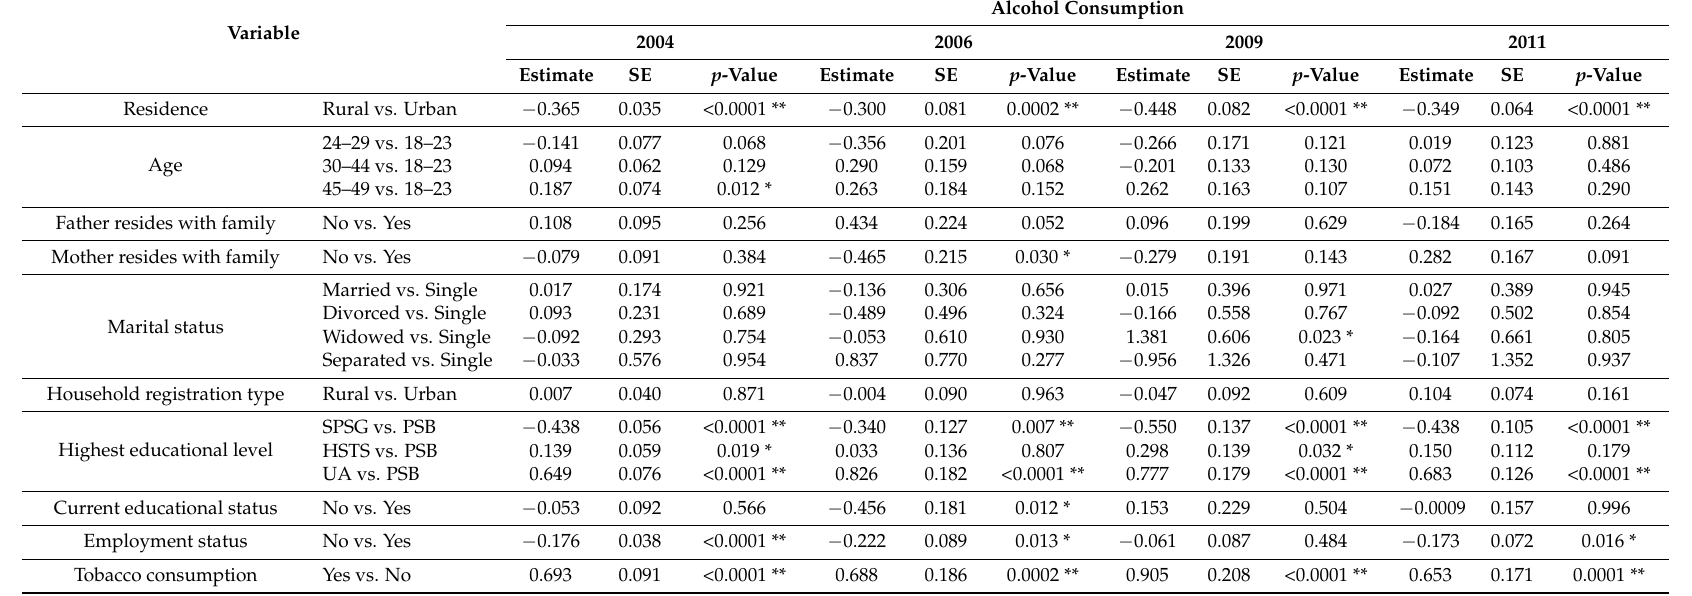
Table 6. Penalized logistic regression analysis for alcohol consumption among adult women of reproductive age (discontinuous